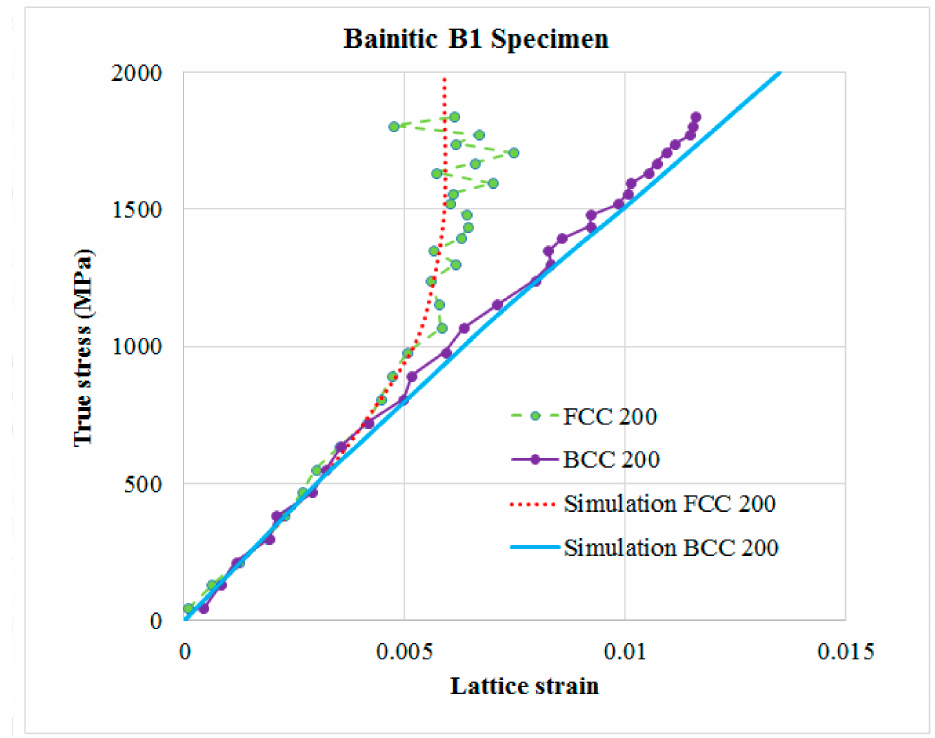
Figure 8. CPFE estimation and experiment results for lattice strains in the bainitic B1 specimen.